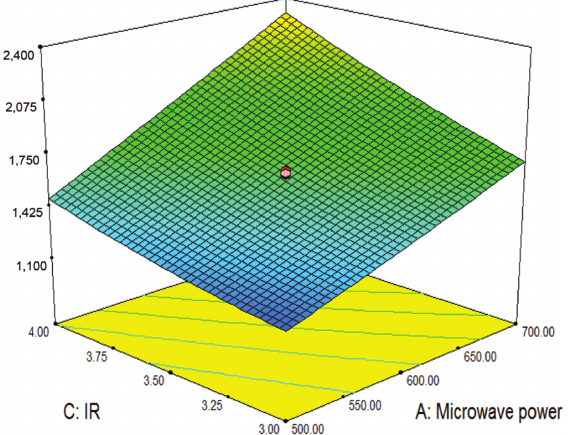
Figure 3: Three-dimensional response surface plot of iodine number: effect of microwave power and activation time on iodine number (KOH/C weight